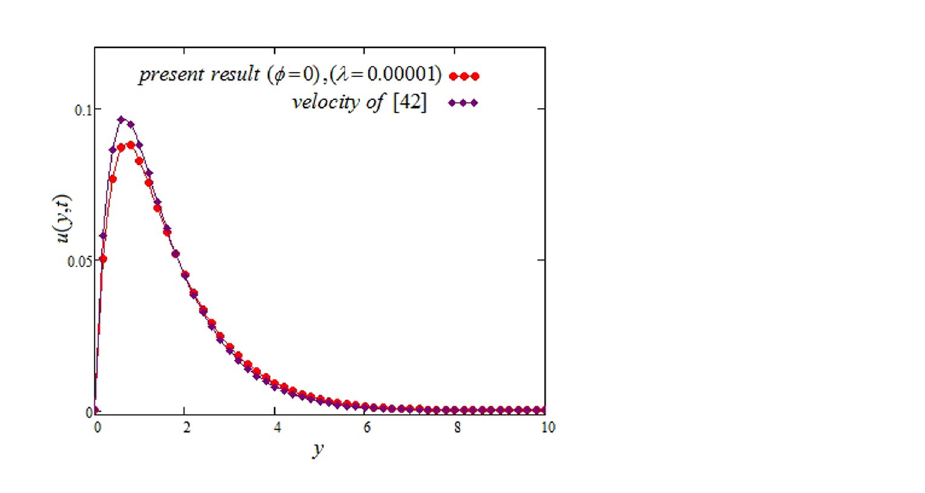
Figure 12. Comparison of velocity profiles for Maxwell and viscous